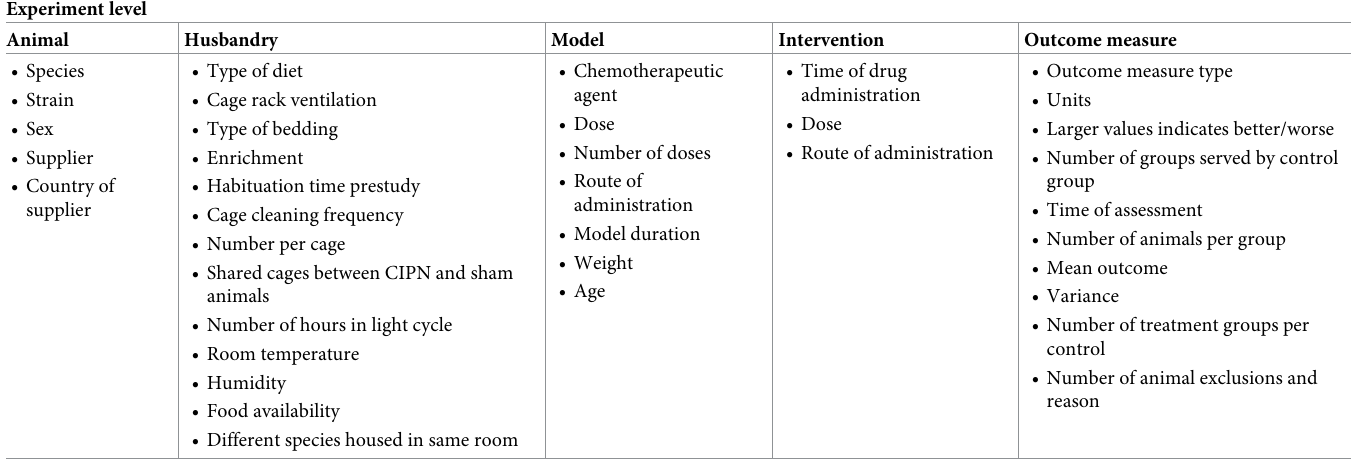
Table 6. Experiment level data abstracted from each